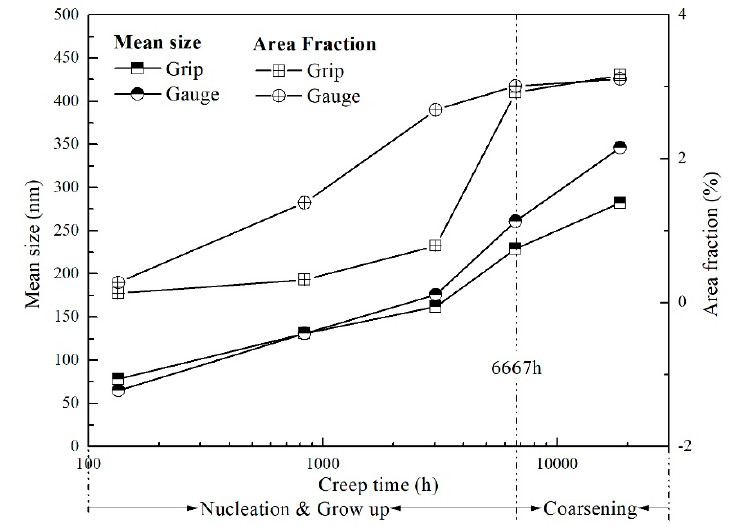
Figure 5. Quantitative analysis of Laves phase evolution during creep.